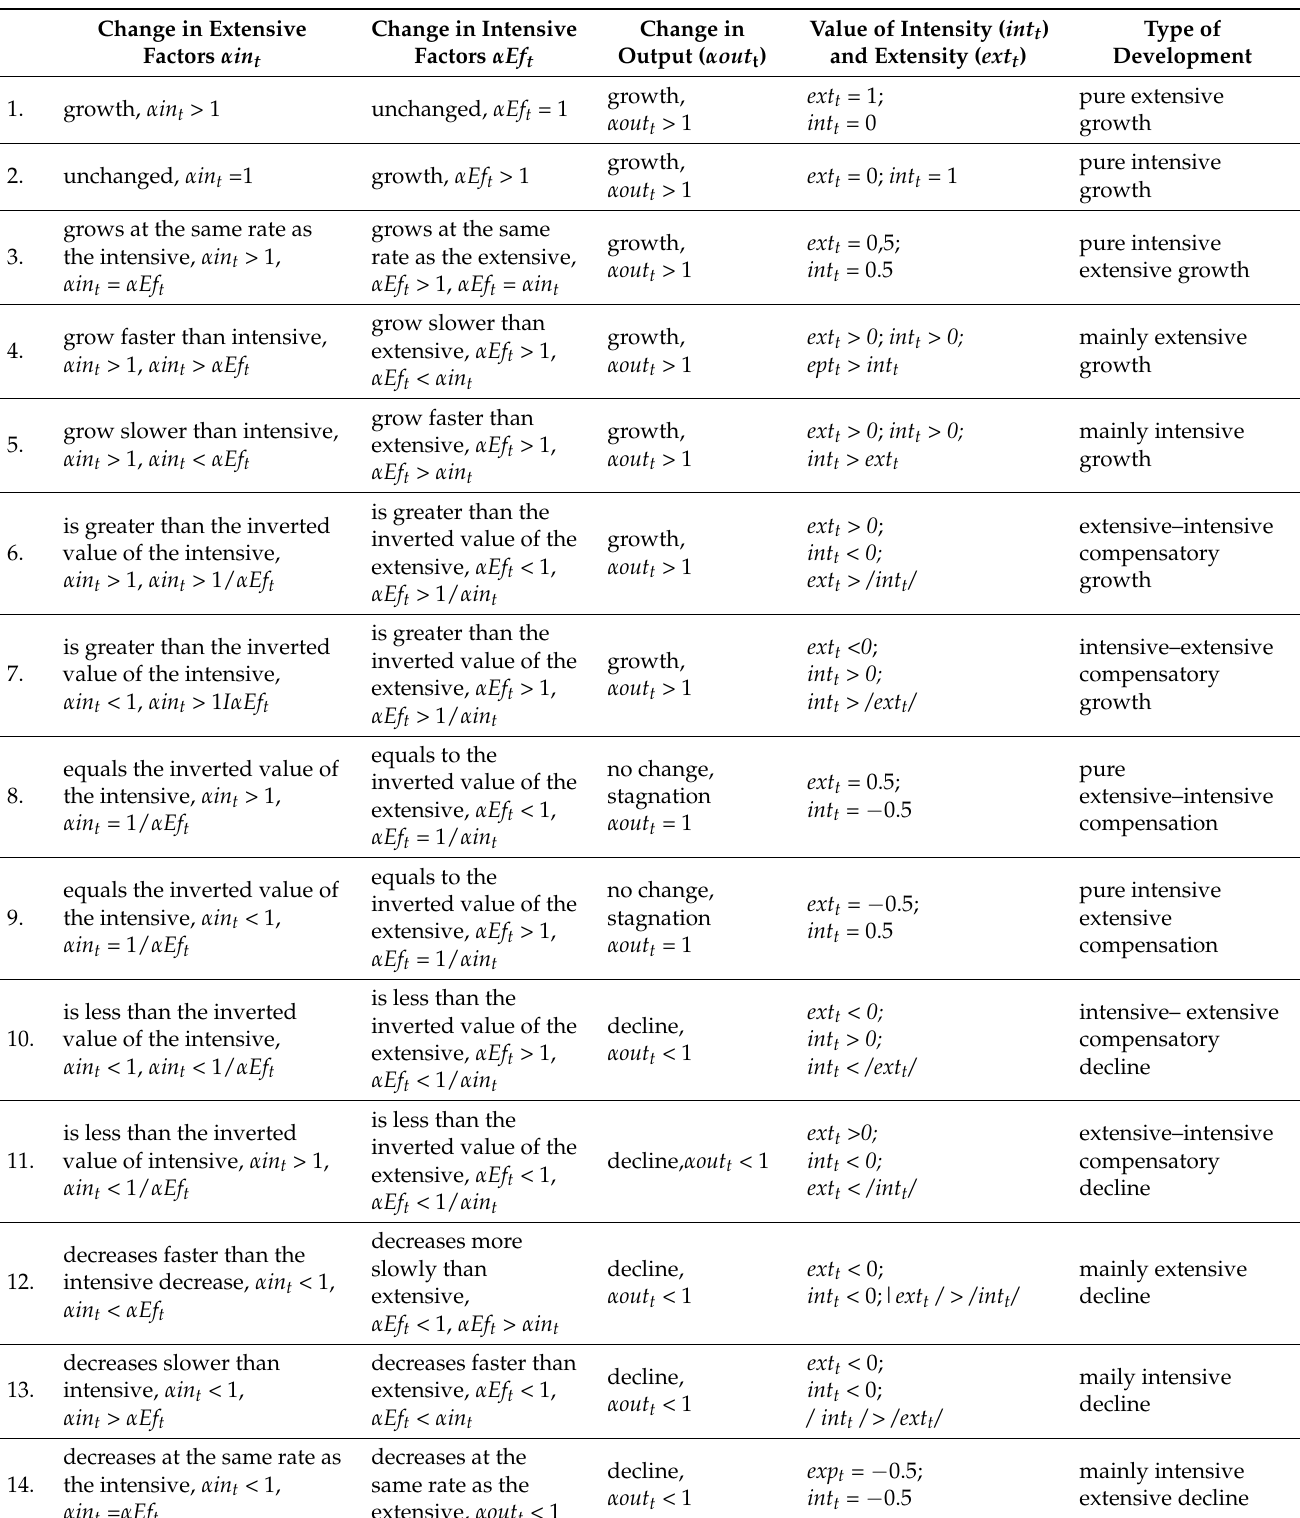
Table 1. All system development types and corresponding values of dynamic intensity and extensity